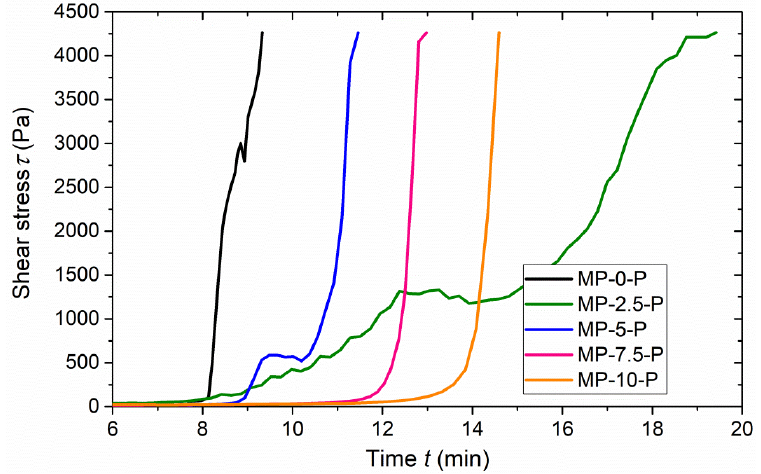
Figure 2. Shear stress development in fresh MKPC